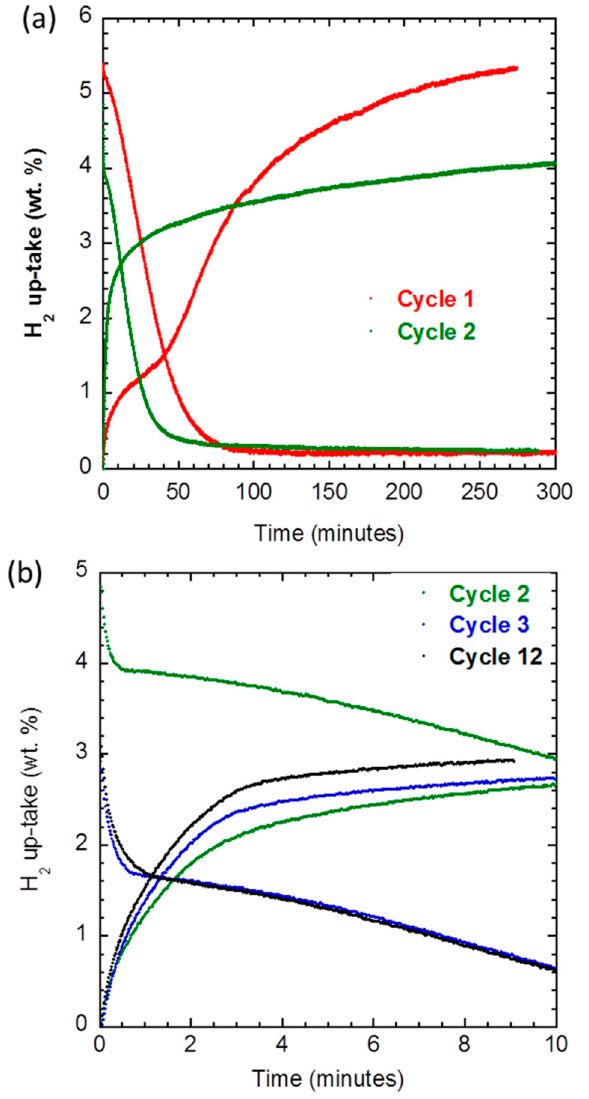
Figure 4. Hydrogen sorption kinetics recorded on Mg-Ni sample forged at room temperature; ( a ) 1st and 2nd hydrogen cycles, ( b ) 2nd, 3rd, and 12th hydrogen cycles. Hydrogen pressure cycles are applied at 310 °C, with respectively 2 MPa and 150 kPa for absorption and desorption steps.